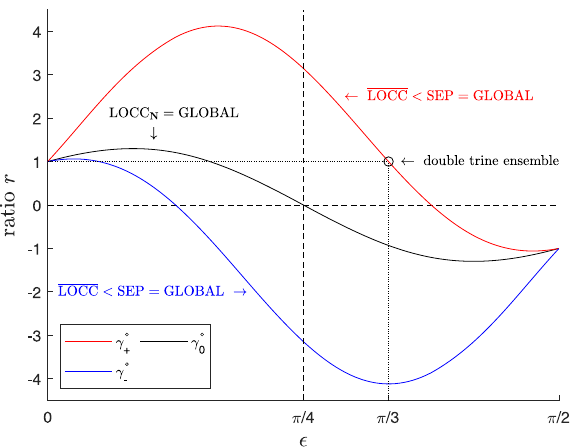
Fig. 3 Appearance of NLWE in a singular case. γ (cid:6) (blue) corresponding to ϵ 2 ð 0 ; π and γ 0 (cid:2) are positive. However, when π Because the ratio r must be positive, when 0 < ϵ < π cases when NLWE occurs and does not. However, when π is impossible to explicitly indicate the occurrence of NLWE. The double trine ensemble corresponds to the case of ϵ ¼ π